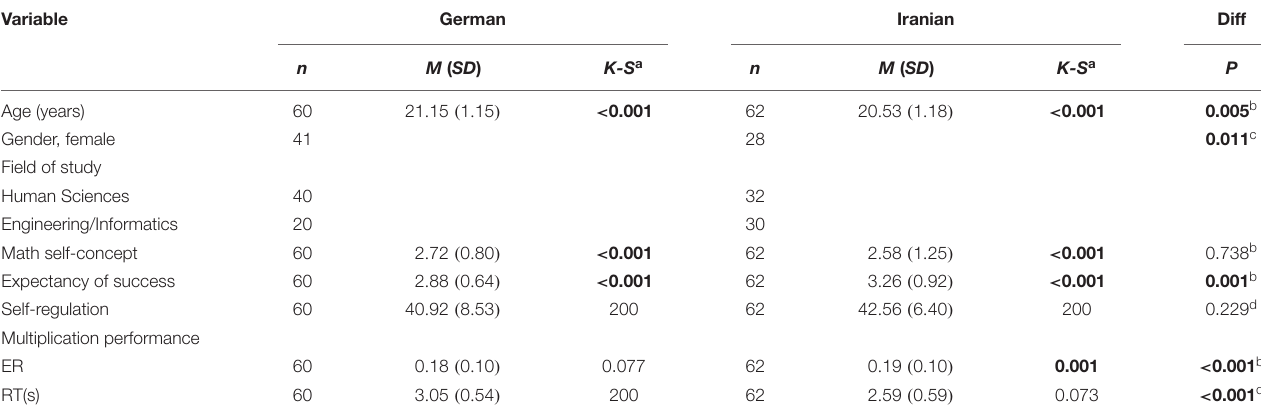
TABLE 1 | Descriptive and test statistics of background characteristics and study measurements.